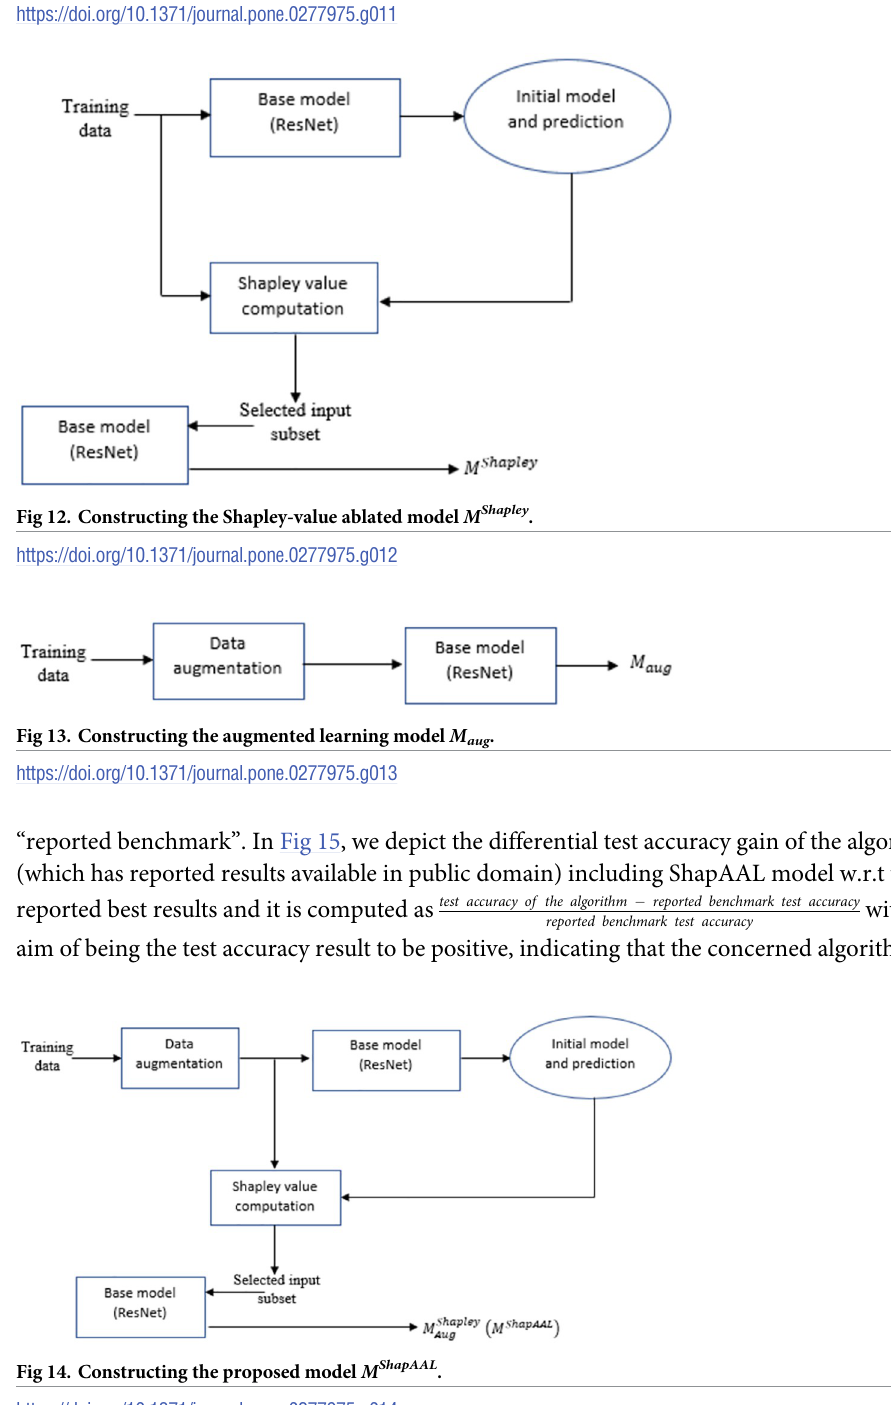
Fig 11. Constructing the base model M .